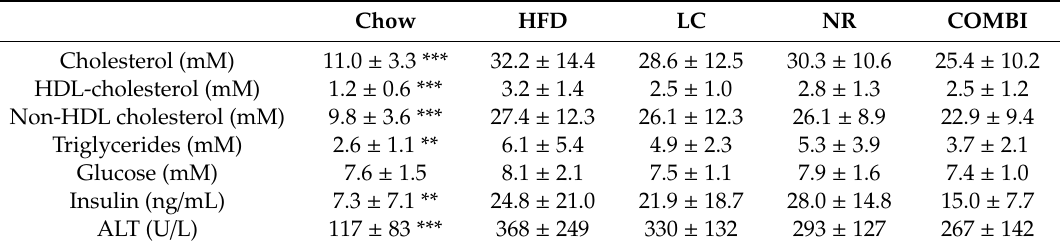
Table 1. Metabolic